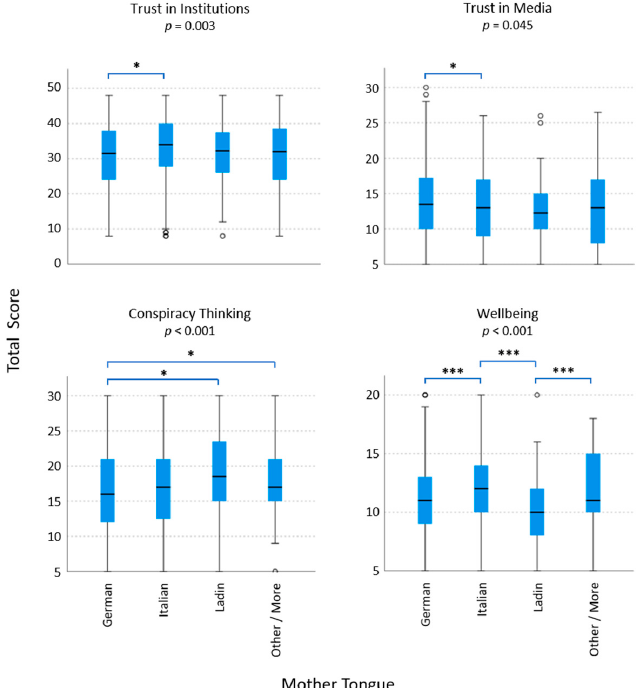
Figure 3. Boxplots of total scores for trust in institutions, trust in media, conspiracy thinking, and well-being of native language groups in South Tyrol during the pandemic. Differences between mother tongues were statistically analyzed in pairs and for multiple groups with pairwise Mann– Whitney tests and Bonferroni correction. For sum scores, see Methods. *, p < 0.05; ***, p < 0.001, and p < 0.05 without Bonferroni